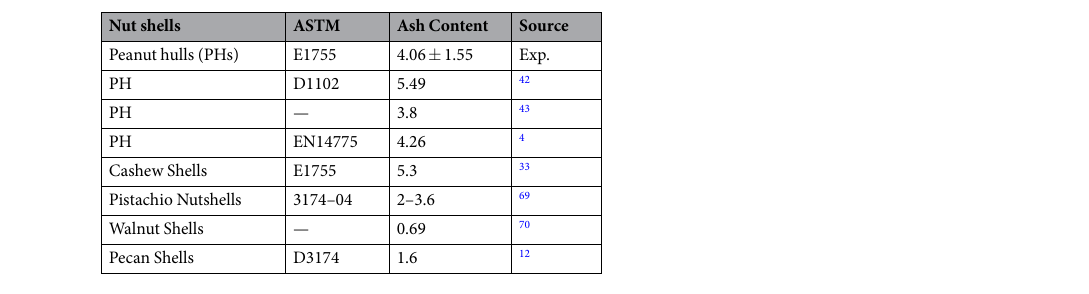
Table 5. Ash content for nuts